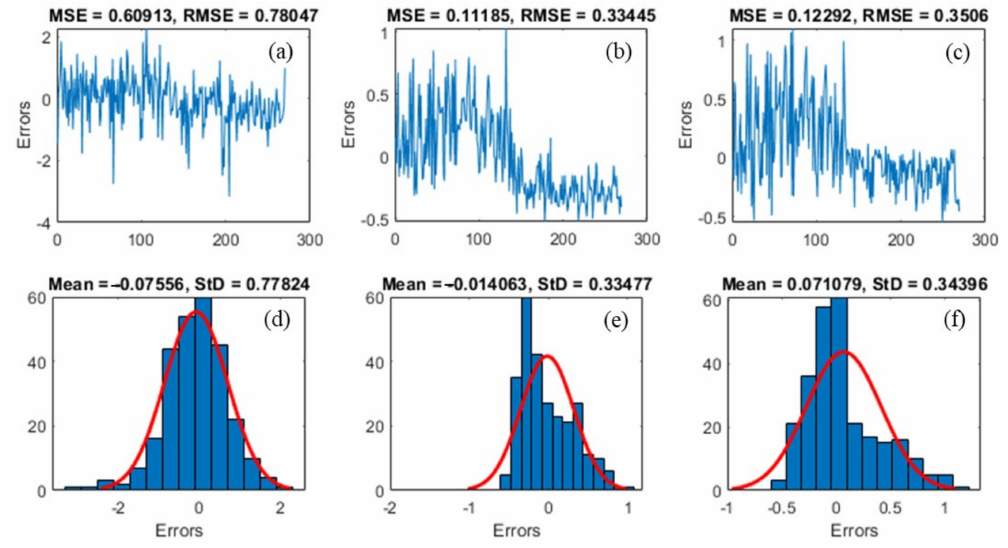
Figure 9. Analysis errors based on MSE, RMSE, error mean, and error StD using a testing dataset for: ( a , d ) CNN, ( b , e ) CNN-GWO, and ( c , f ) CNN-ICA